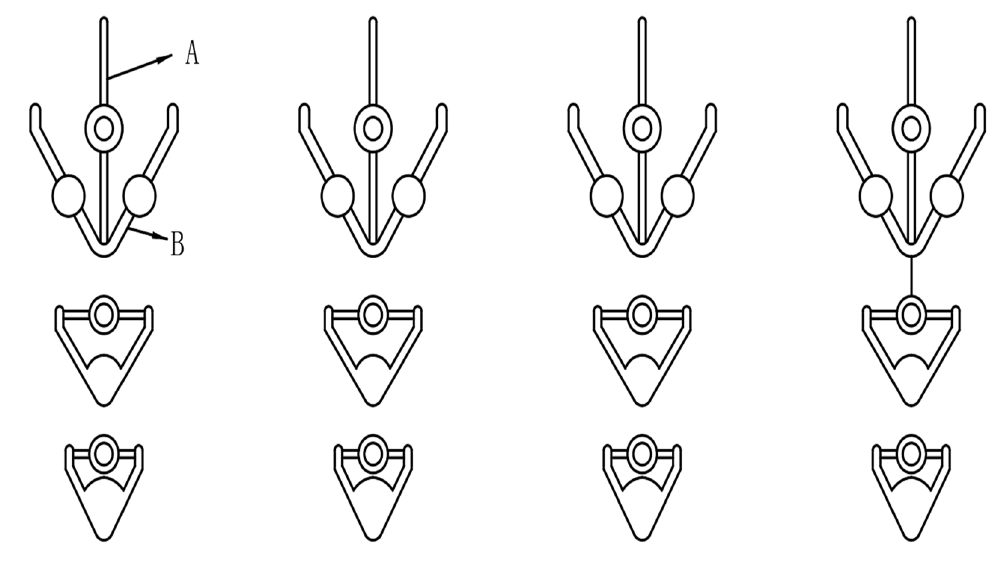
Figure 1. Design structure of cryoarrays of CFETR NNBI.